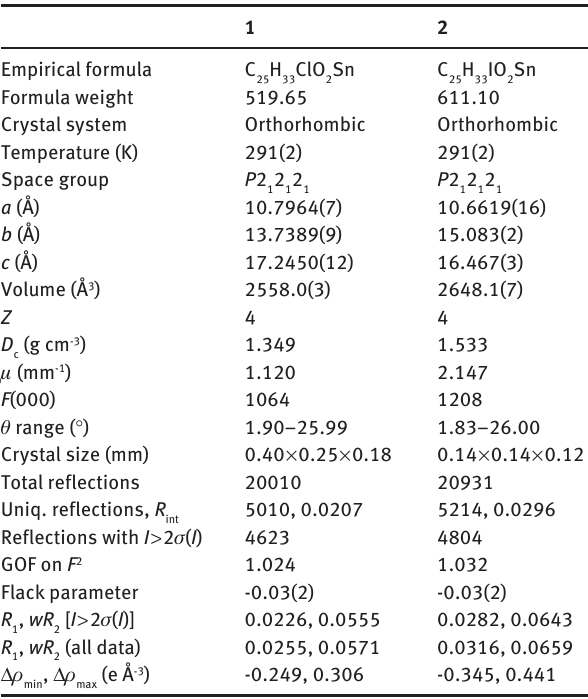
Table 2: Crystallographic data and structure refinements of 1 and 2